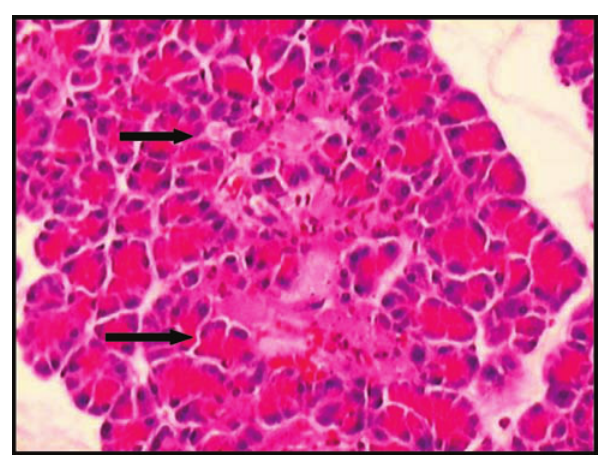
FIGURE 2 - Fotomicrograph. Steatonecrosis. Group C,